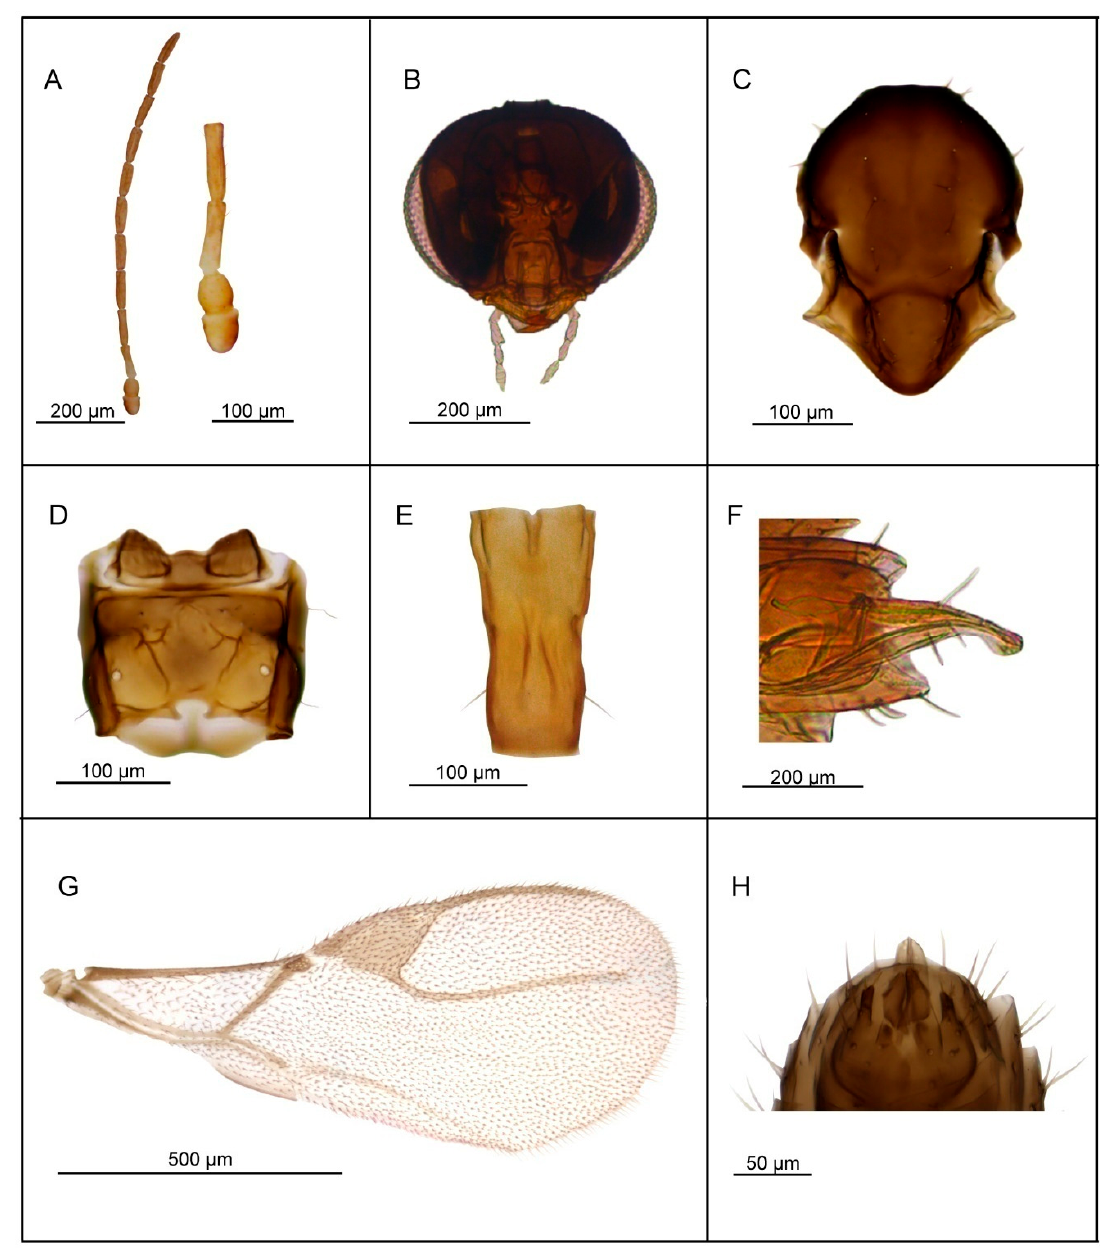
Figure 7. Lipolexis pelopsi sp. n.: female ( A ) antenna and F1 and F2; ( B ) head; ( C ) mesoscutum; ( D ) propodeum; ( E ) petiole, dorsal view; ( F ) ovipositor sheath; ( G ) forewing; male ( H ) aedeagus. Female